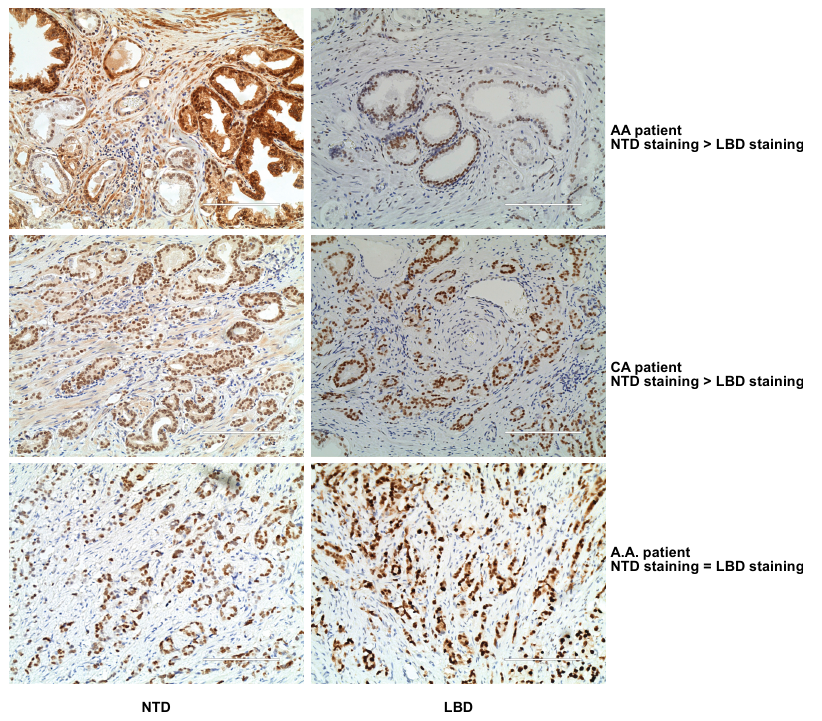
Figure 4. NTD and LBD antibody staining representative images from three patient specimens.